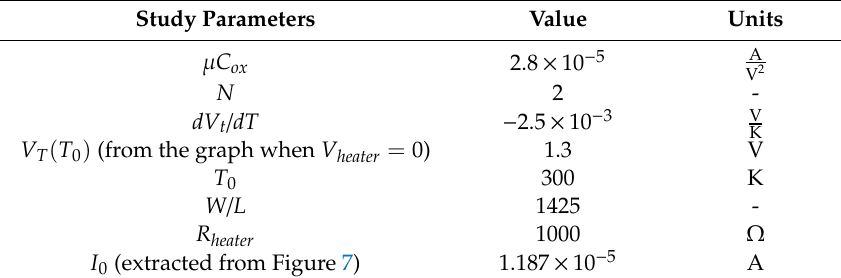
Table 2. Typical values for the CMOS-SOI process of the fabricated DUT.